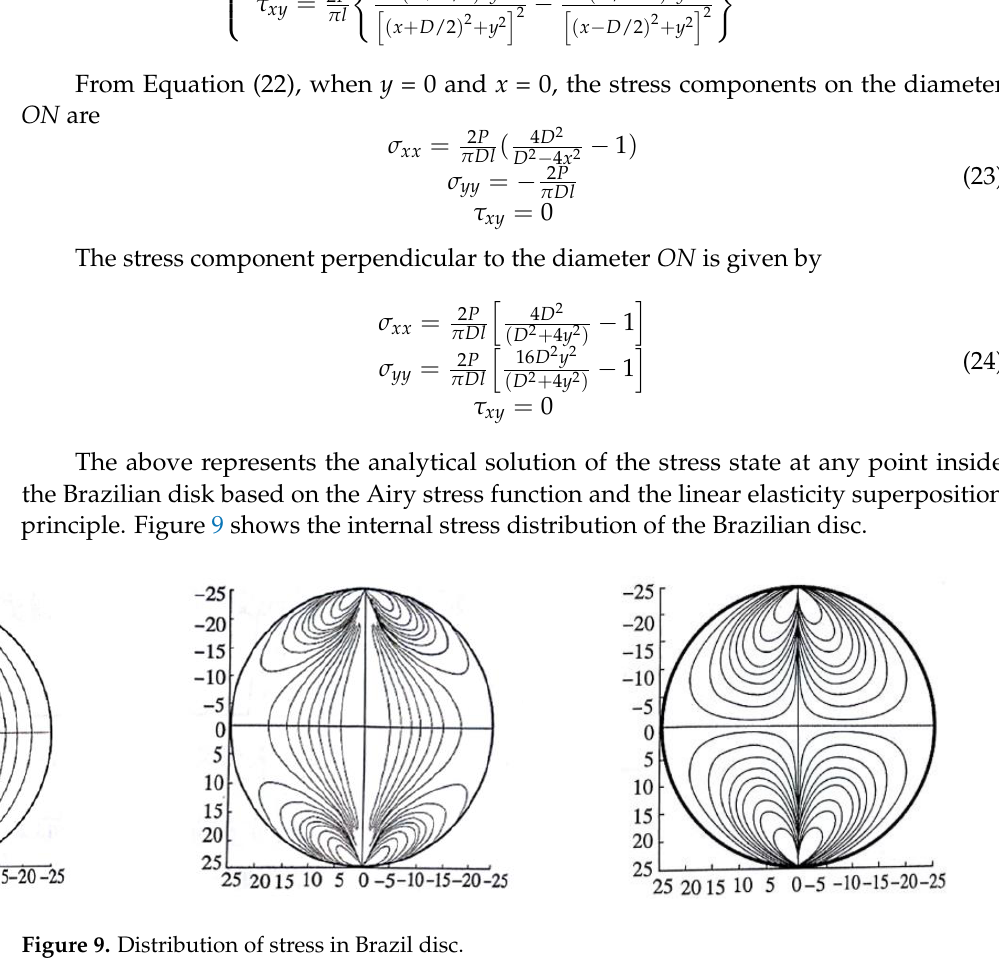
Figure 9. Distribution of stress in Brazil disc.